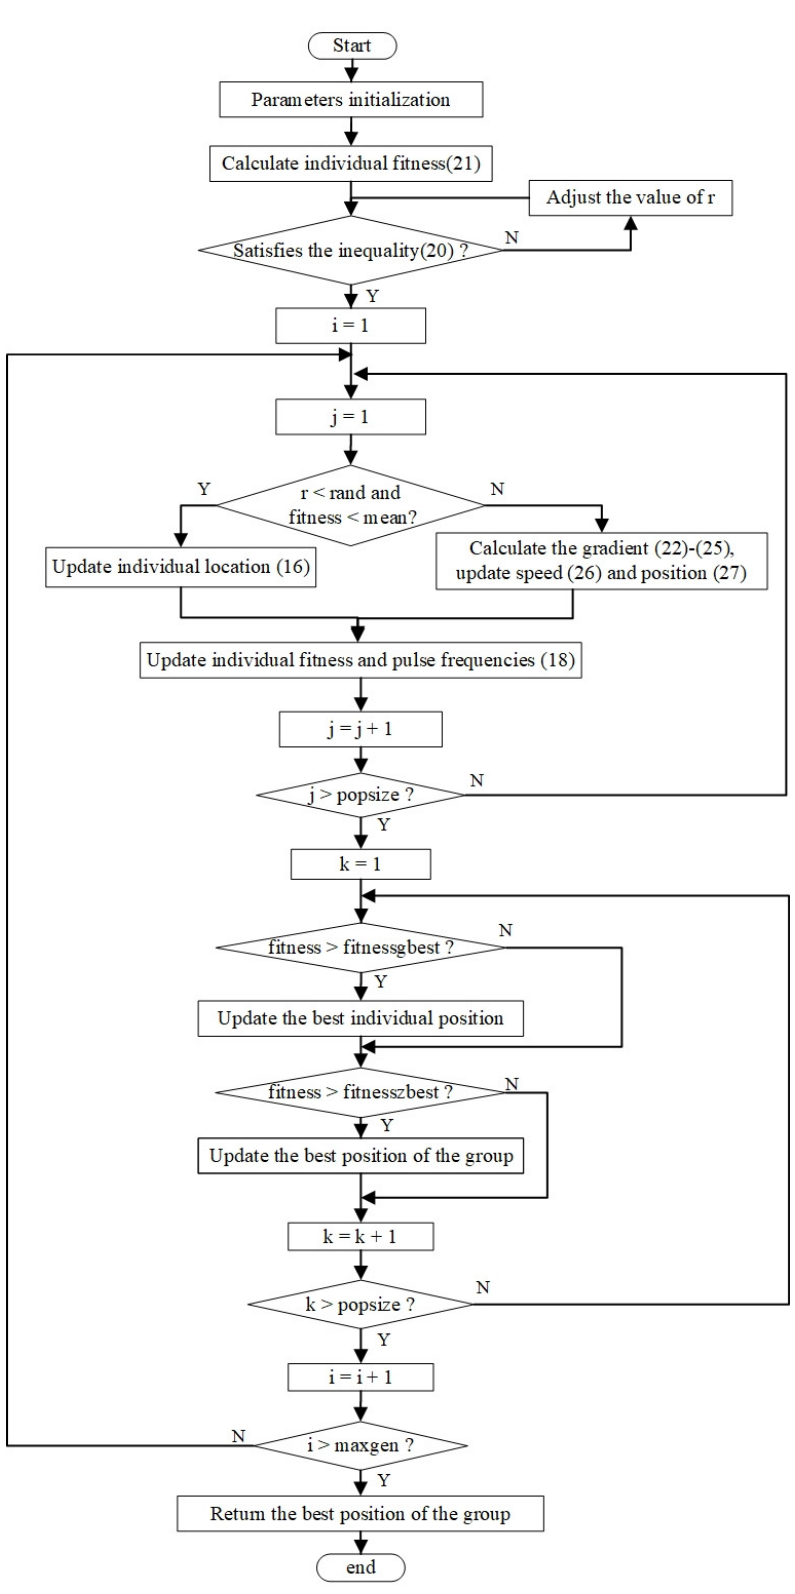
Figure 2. The flow chart of